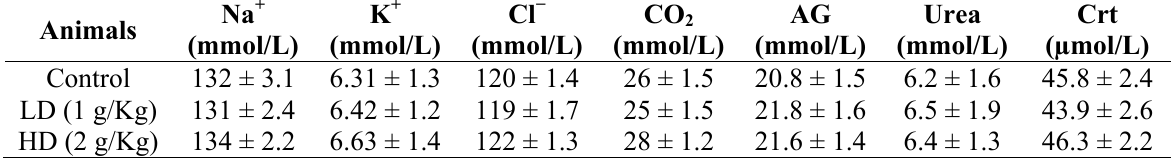
Table 2. Renal function test of rats in acute toxicity study of CuLBS compound.